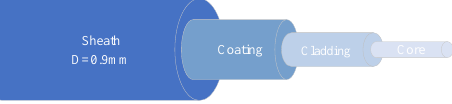
Figure 1. Structure of optical fiber.